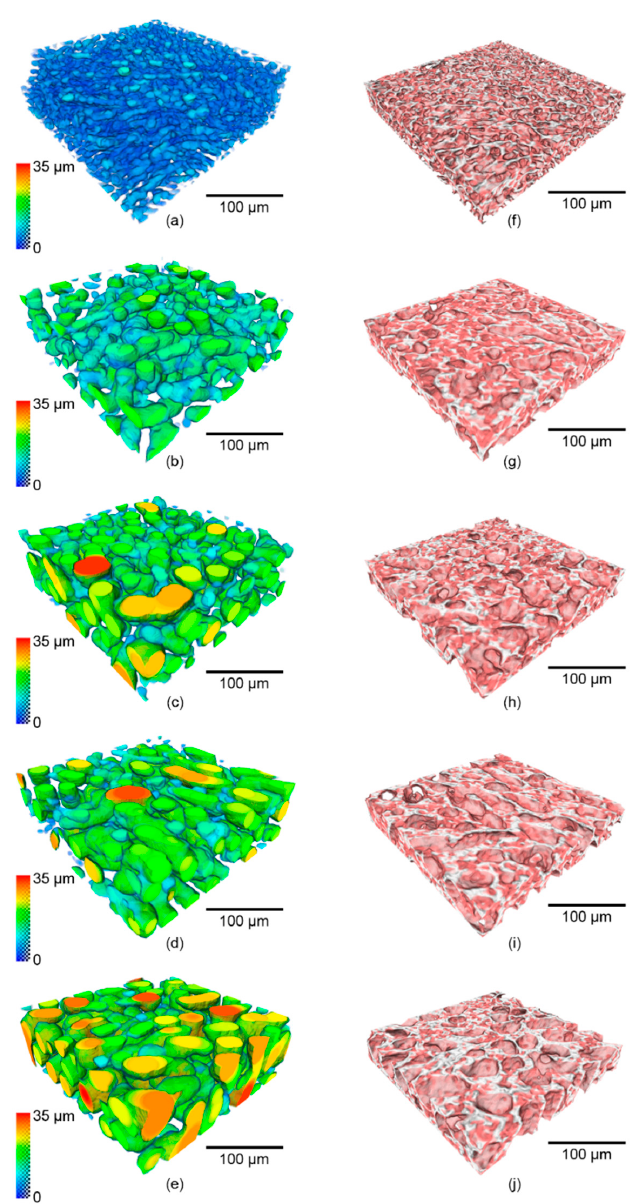
Figure 6. The 3D morphological evolution of representative volumes of ( a – e ) ice crystals and ( f – j ) the unfrozen matrix during the in situ experiment. ( a , f ) show the ice crystals and un-frozen matrix after the fast cooling (FC) and holding at 250 K. During the slowing cooling (SC) period, the ice crystals, and un-frozen matrix are shown for the following temperatures: ( b , g ) 266.8 K, ( c , h ) 263.4 K, ( d , i ) 260.8 K, and ( e , j ) 250 K respectively. In ( a – e ), the color of the renderings correlates with the 3D local thickness of the ice crystals.